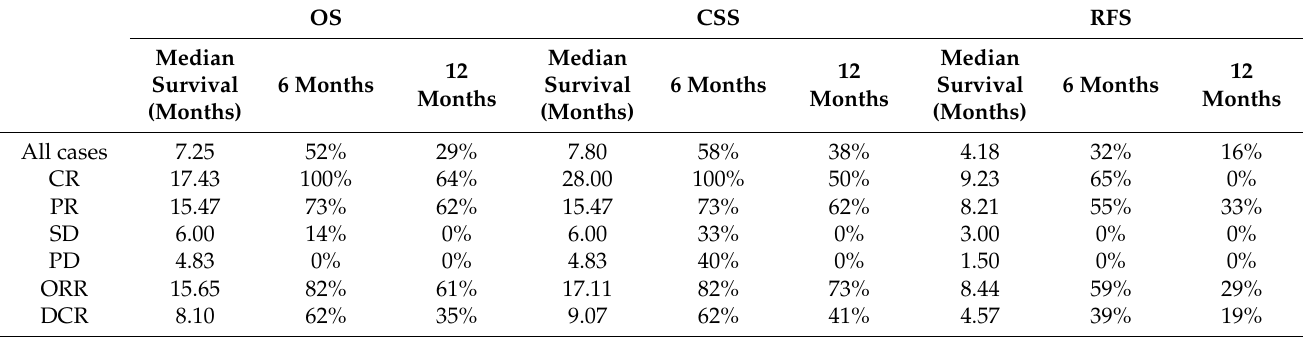
Table 3. The 6- and 12-month OS, CSS, and RFS in patients with CR, PR, SD, and PD. OS CSS